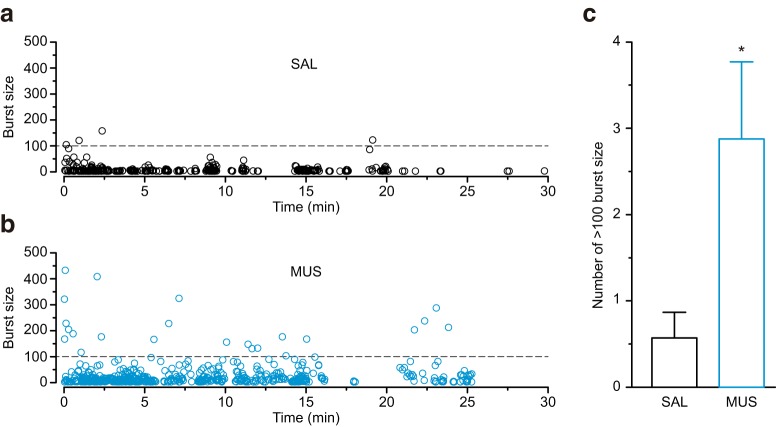
The intra-BLA muscimol increased larger burst size. Plots for all burst sizes in the saline-injected (SAL) and muscimol-injected (MUS) groups for Test 2. a, The size of almost all the bursts was <100 licks in the SAL group. b, The MUS group showed a larger number of lick bursts containing over 100 licks. c, There was a significant group difference in the average number of >100 lick burst size; *p < 0.05 (vs SAL).